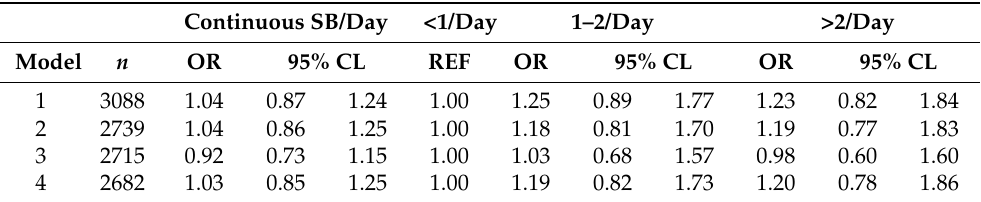
Model 1: adjusts for total energy intake. Model 2: model 1 + sex, maternal education, mater- nal pre-pregnancy body mass index, and breastfeeding duration. Model 3: model 2 + body mass index category at 24 years. Model 4: model 2 + AUDIT-C (Alcohol Use